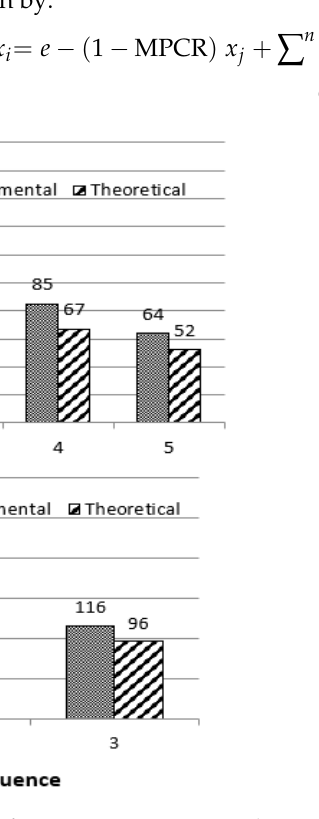
Figure 3. Empirical and predicted mean of requests in a sequential CPR Dilemma with resource size = 500 for n = 5 players (upper panel) and n = 3 players (lower panel).